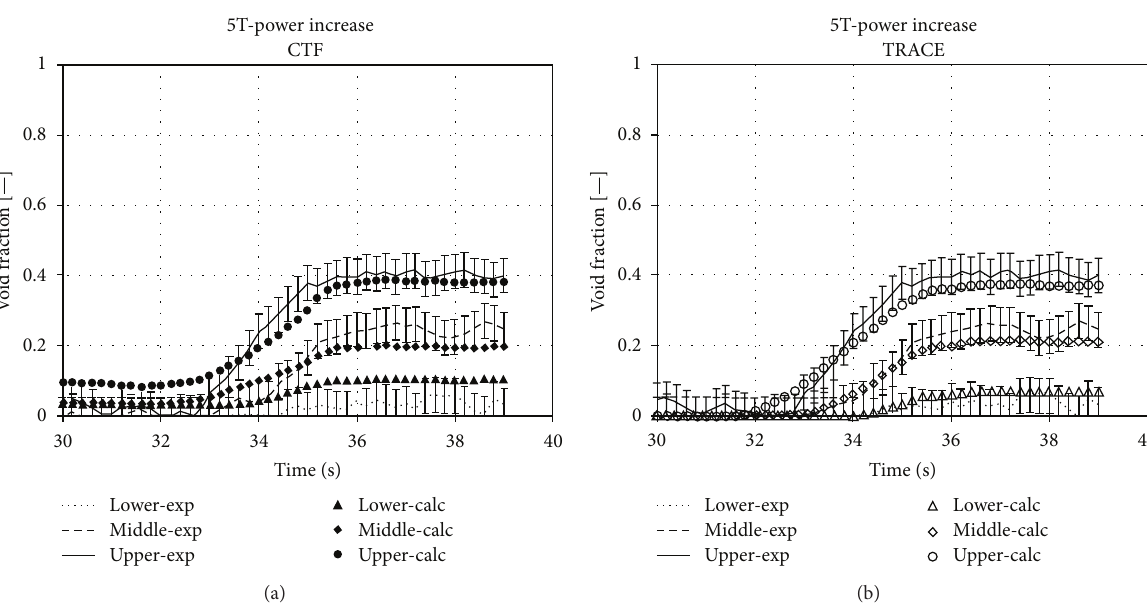
Figure 3: CTF (a) and TRACE (b) predictions of void fraction in bundle type B5 during flow reduction transient.